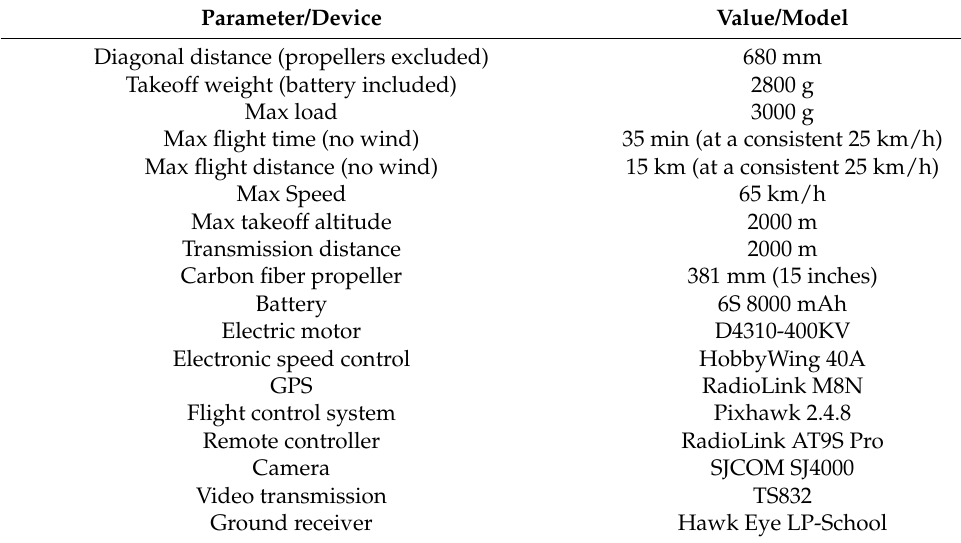
Table 1. Parameters and devices for FPCS.